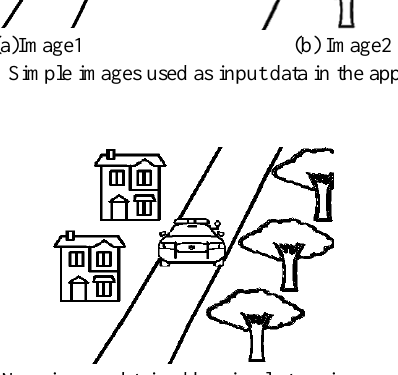
Figure 6. New image obtained by simple two-image merging. When the merging algorithm is applied on the gray images shown in Figure 7.(a) and (b), the merging of the images has been performed (Figure 7.c).